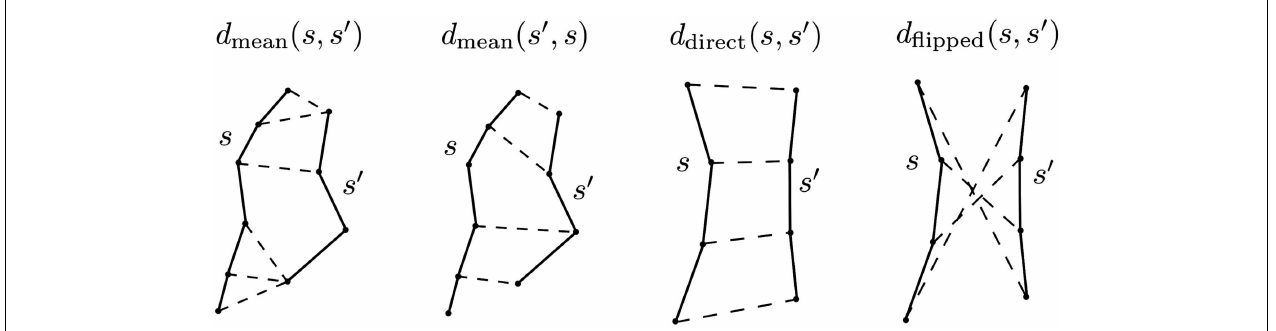
points: MAM mean = ( d mean ( s , s (cid:48) ) + d mean ( s (cid:48) , s )/2 [see equation (5)]. In this figure the components of both distances are shown; the streamlines are drawn with solid lines, and then with dashed lines we connect the pairs of points of the two streamlines whose distances contribute to the overall metric. Note that we cannot calculate the MDF between the streamlines on the left of the figure because they have different numbers of